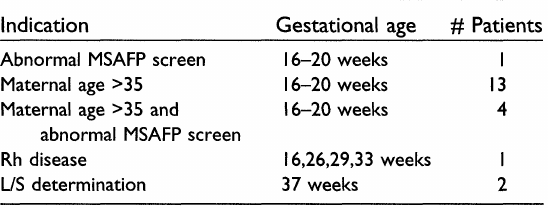
TABLE I. Indication and gestational age at the time of